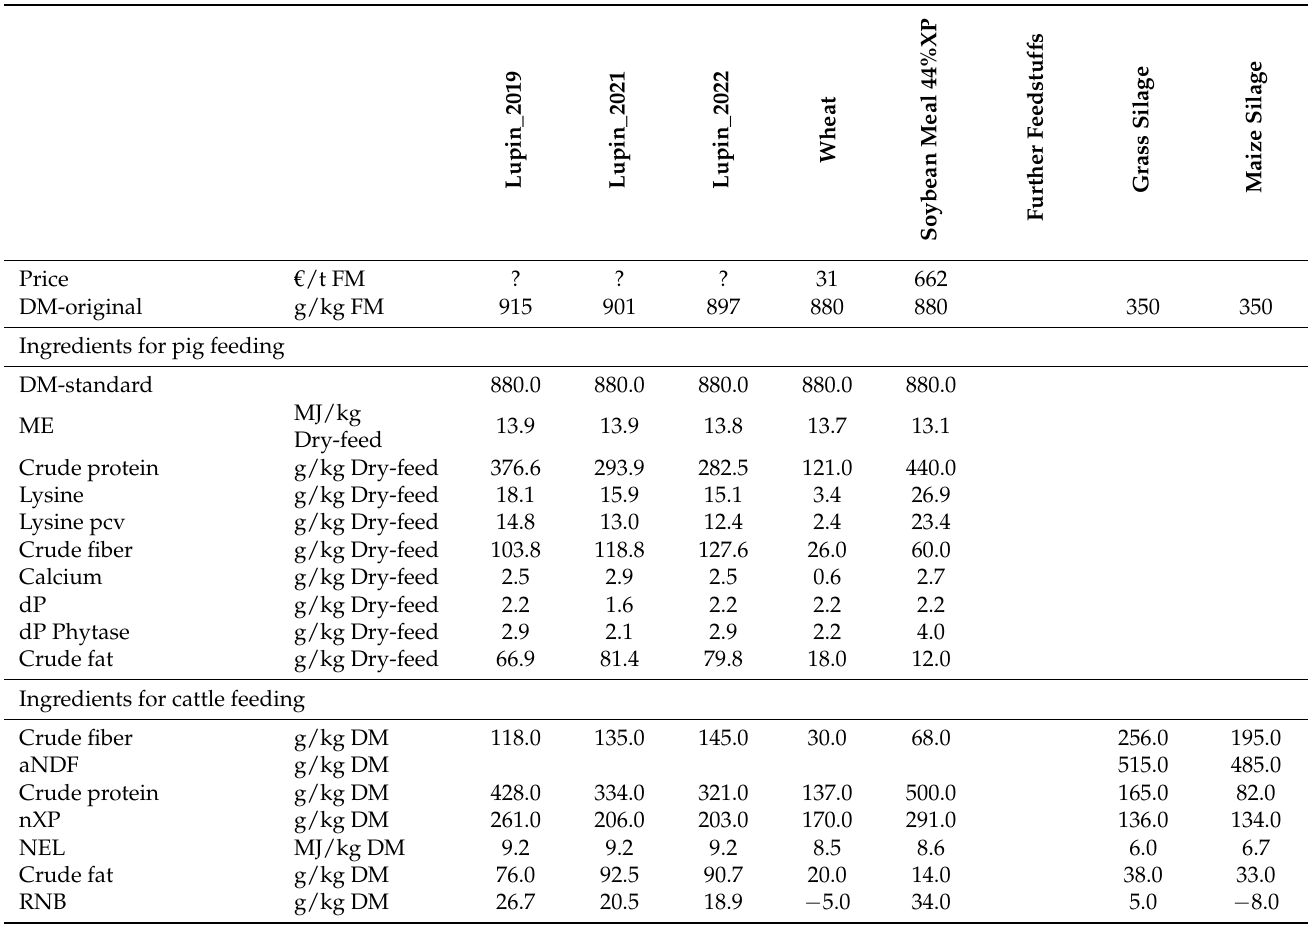
Table 1. Feedstuff table (excerpt).